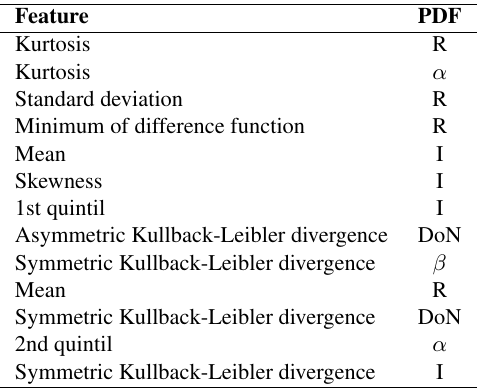
Table 6. Feature selection for the binary classification of dormer types (gabled and shed) based on simulated data. I: inclination distribution, R: residual distribution.